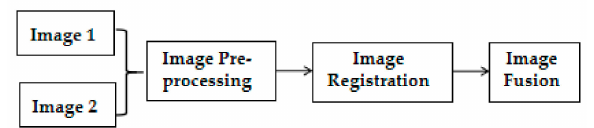
Figure 10. Flow chart outline of image